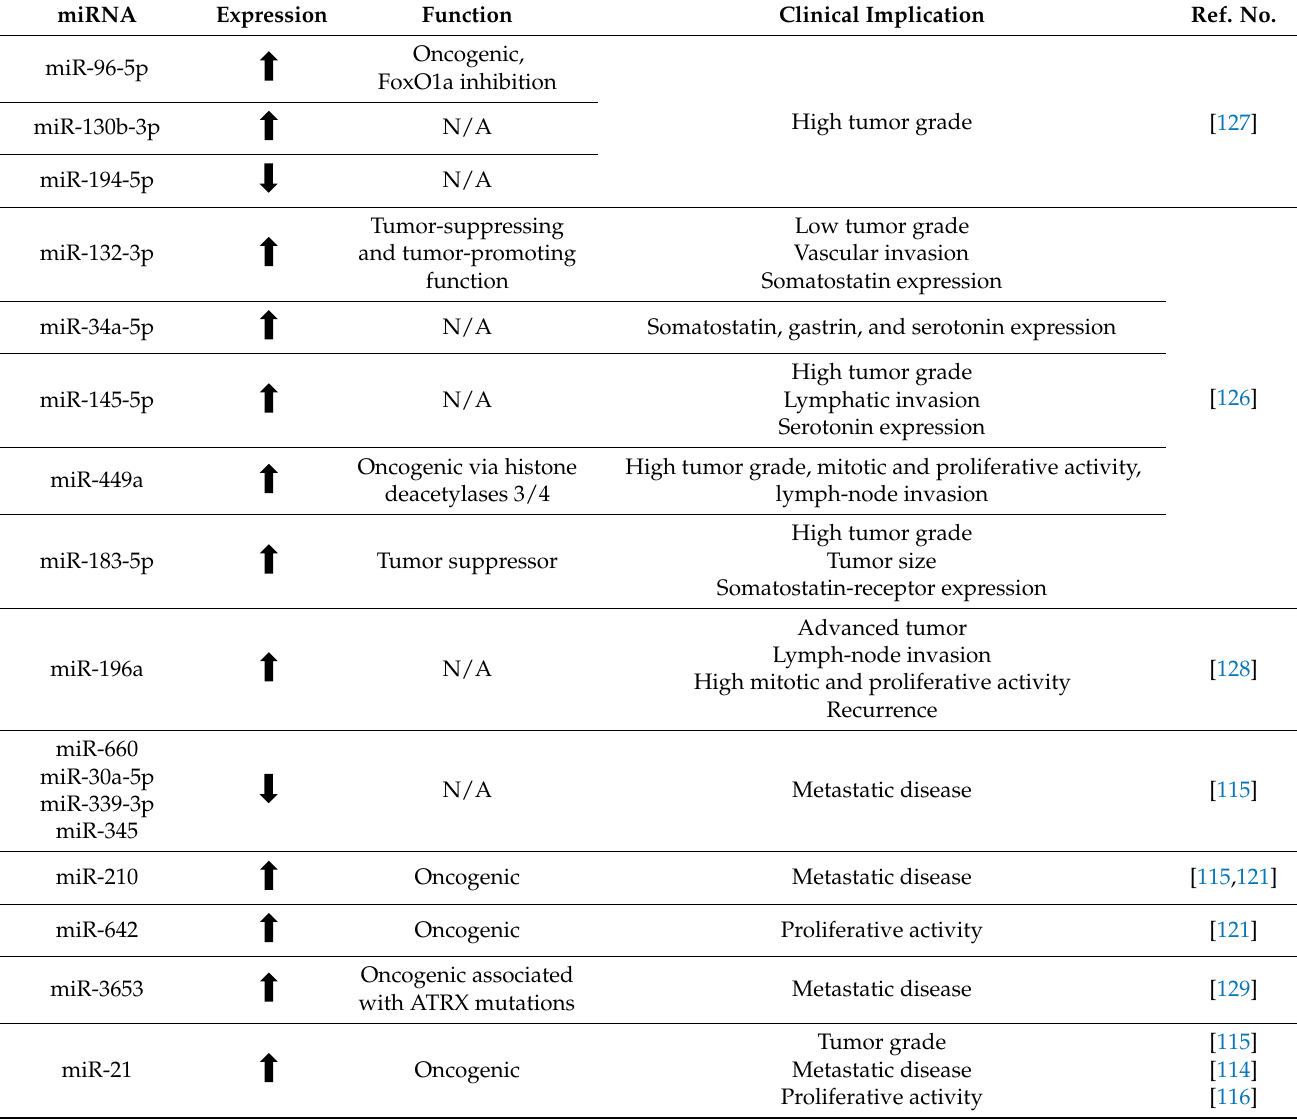
Table 1. The prognostic role of miRNAs in PanNETs.